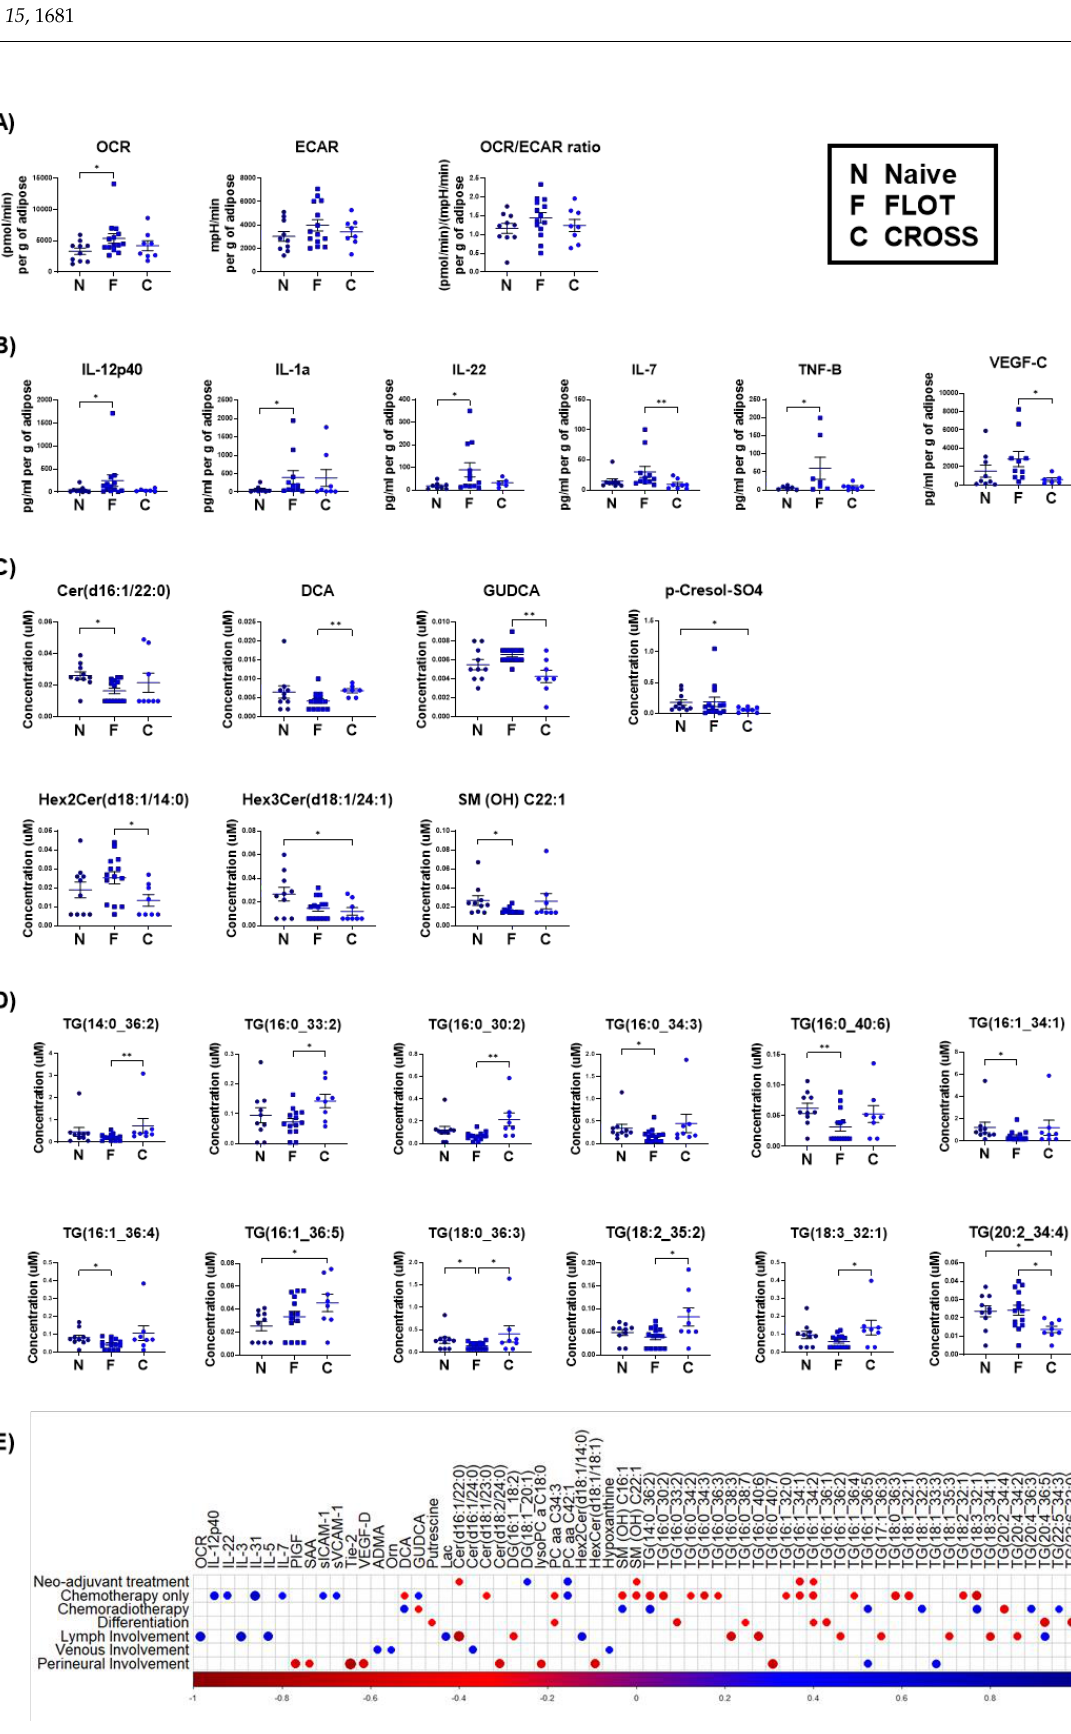
Figure 3. Alterations in OCR, pro-inflammatory cytokines and metabolites in adipose explants from OAC patients correlates with previous treatment exposure ( A ) OCR, ECAR, and OCR:ECAR ratio